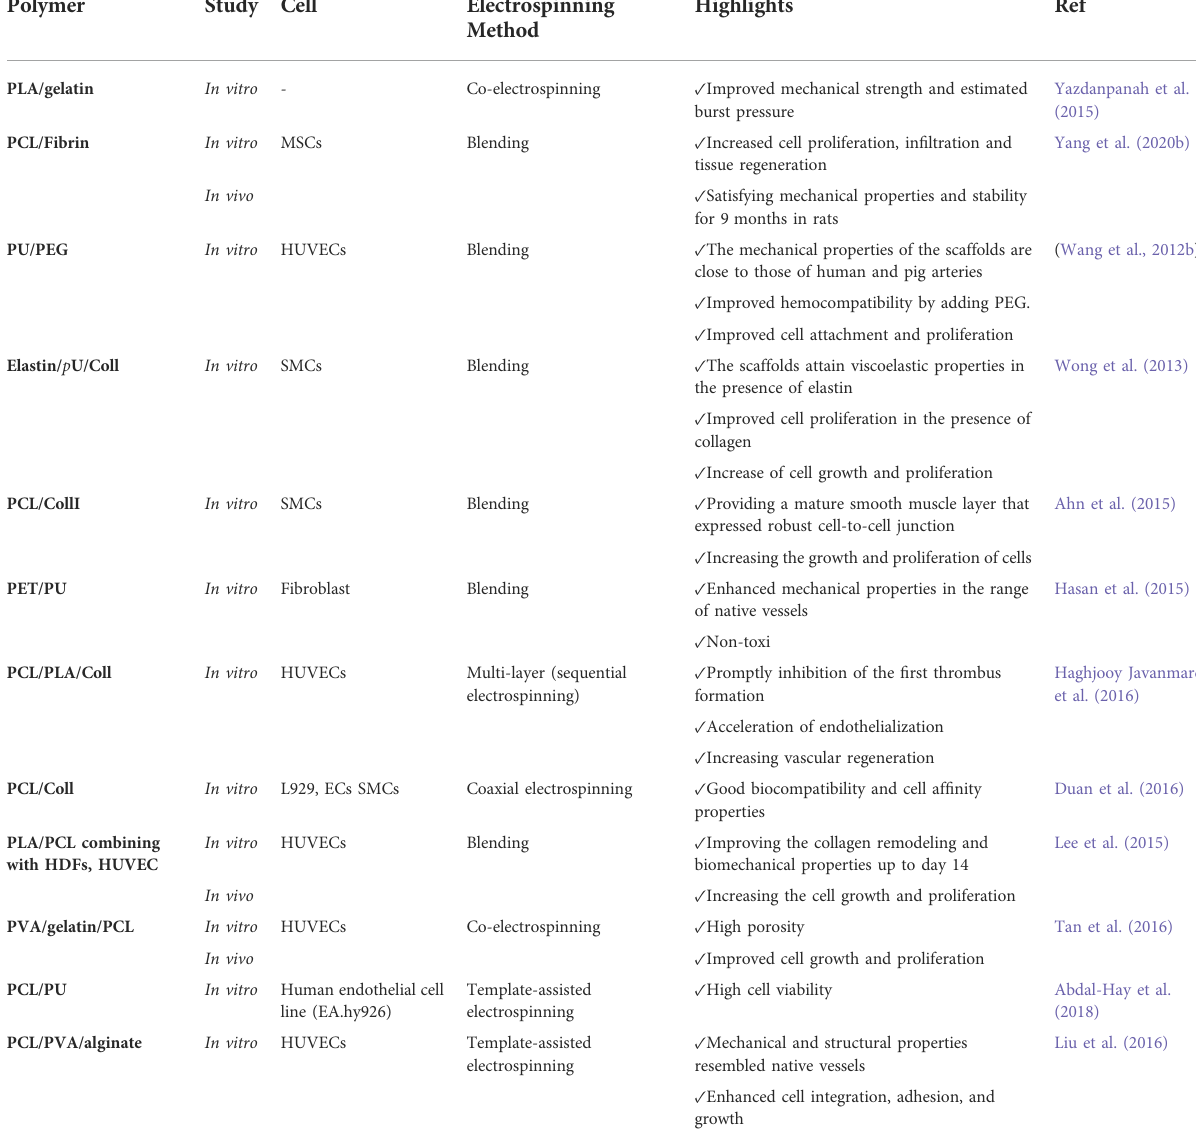
TABLE 6 An overview of electrospun hybrid nano fi ber for vascular tissue engineering.